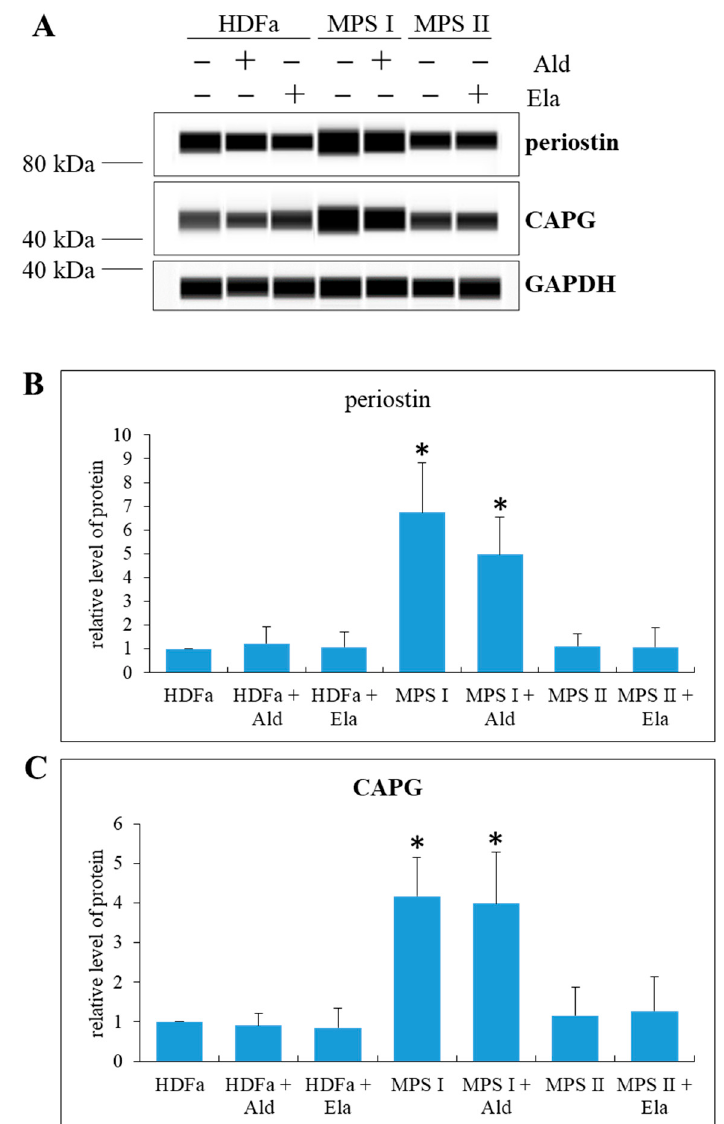
Figure 12. Levels of periostin and CAPG proteins in MPS fibroblasts in comparison to control cells (HDFa cell line) with and without treatment with 0.58 mg/L α -L-iduronidase (Aldurazyme, Ald) or 0.5 mg/L iduronate sulfatase (Elaprase, Ela) for 24 h. Representative Western-blots are demonstrated in ( A ), while quantification of relative levels (assuming 1 as the value in untreated HFDa cells) of periostin and CAPG are shown in ( B , C ), respectively. Mean values ± SD are presented, with asterisks and hashtags representing statistically significant ( p < 0.05) differences relative to the HDFa control and untreated MPS, respectively.